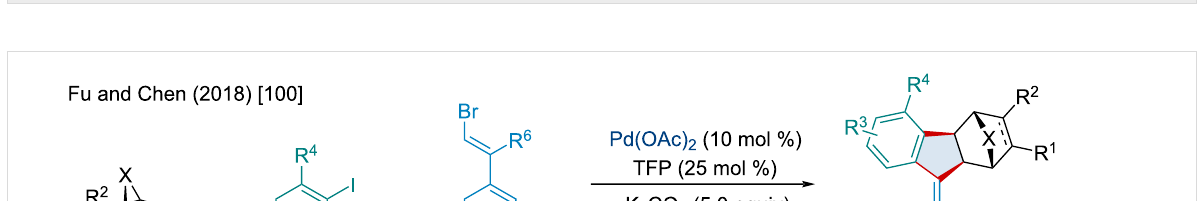
Scheme 45: Pd-catalyzed arylboration and allylboration of bicyclic alkenes.